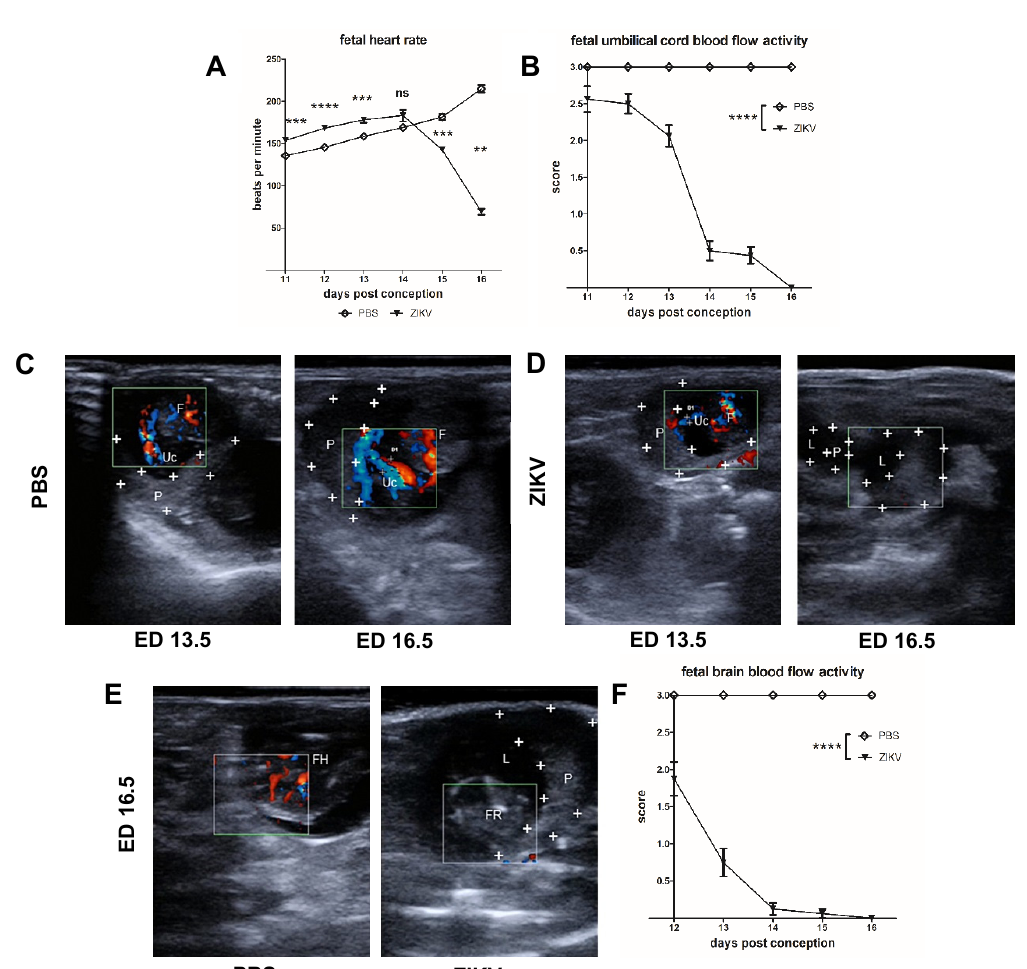
Figure 2. Ultrasound based demonstration of fetal blood flow activity and heart rate measured by Doppler ultrasound; A + B: Pregnant interferon receptor-deficient (IFNAR-/-) mice were inoculated with PBS (mock-infected animals, used as controls) or with 10 3 plaque-forming-units (PFU) ZIKV on embryonic day 7.5 (ED 7.5). In all experiments, heart rates of individual fetuses were monitored daily ( n = 6-8– fetuses per group). Data are representative of two experiments. Here: Graphical summary of the data obtained by Doppler measurements of uterine vessels blood flow activities (Figure 1A: error bars indicate SEMs and differences between the groups were analyzed by unpaired, two tailed t-test. Asterisks represent statistically significant differences between two groups; n = ns, ** p = 0.0012, *** p = 0.0002, **** p < 0.0001, Figure 1B: error bars indicate SEMs and differences between the groups were analyzed by two-tailed t-test after calculation of the area under the curve, **** p < 0.0001); C + D : Measurement of the utero-placental blood flow activity in the uterine vessels obtained by Doppler-ultrasound on ED 13.5 and 16.5 for the PBS control mice and the ZIKV-infected mice.; E: Measurement of the blood flow activity in the fetal heads obtained by Doppler-ultrasound on ED 16.5 for the PBS control mice and the ZIKV-infected mice; F: Graphical summary of the data obtained by Doppler measurements of blood flow activities in the fetal heads ( n = 6–8 fetuses per group); error bars indicate SEMs and differences between the groups were analyzed by two-tailed t-test after calculation of the area under the curve, **** p < 0.0001.